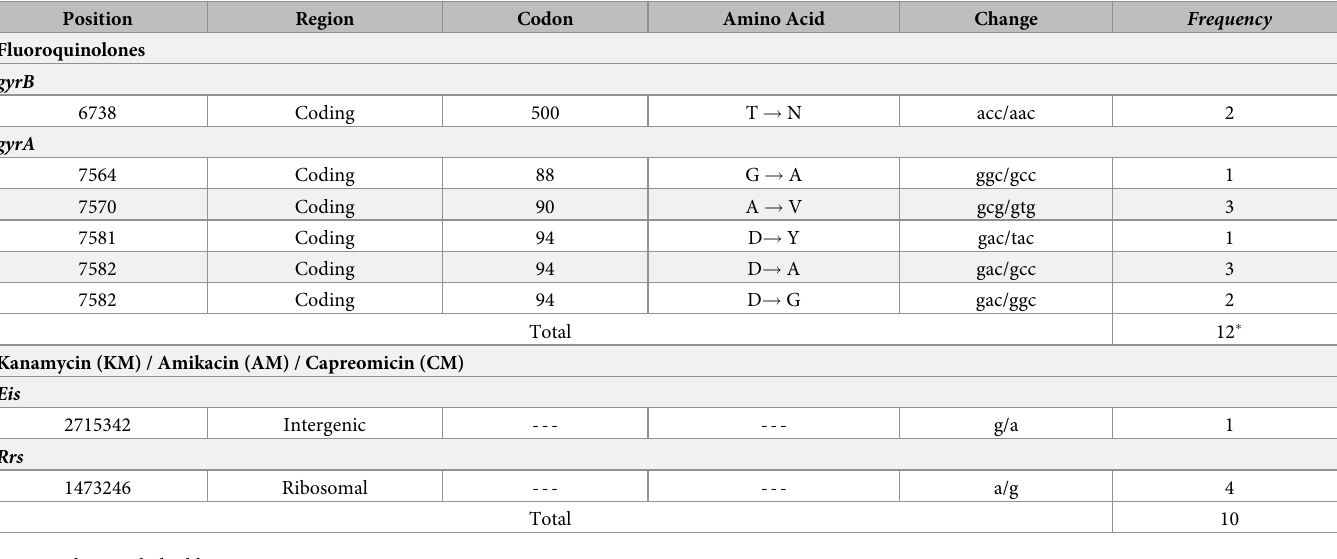
Table 6. Second line drug mutations determined through WGS from isolates of Mycobacterium tuberculosis circulating in Veracruz, Mexico. Position Region Codon Amino Acid Change Frequency